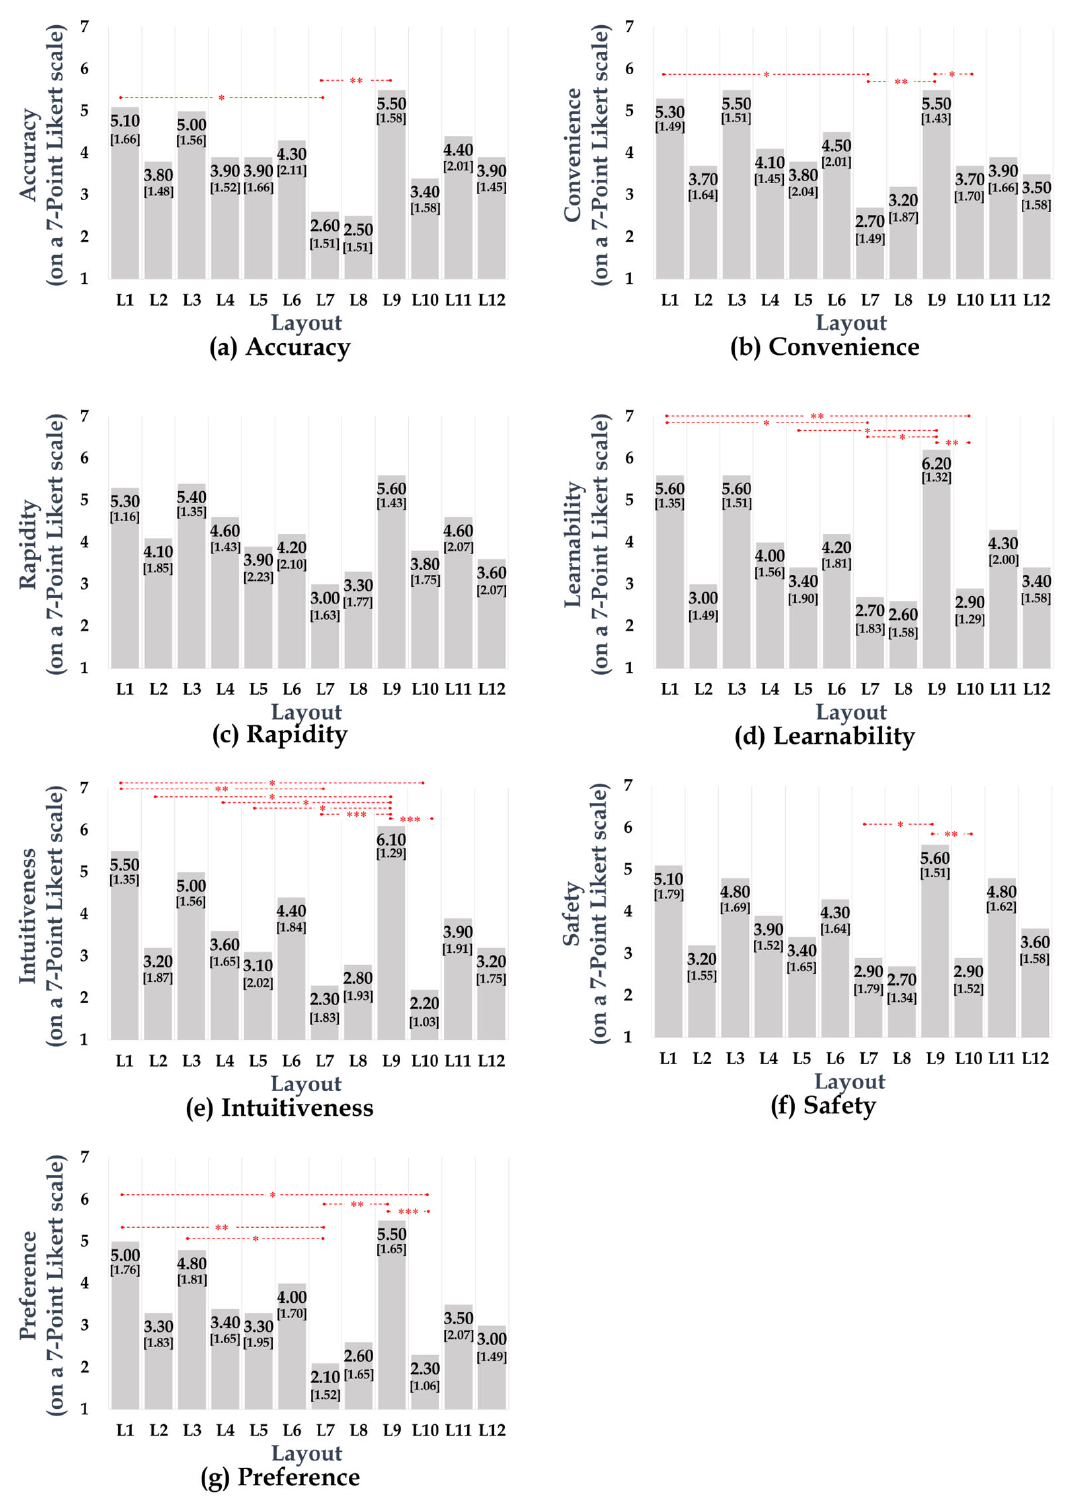
Figure 3. Mean and standard deviation of each subjective rating measure for each layout in the experienced driver group: ( a ) accuracy, ( b ) convenience, ( c ) rapidity, ( d ) learnability, ( e ) intuitiveness, ( f ) safety, and ( g ) preference. * p < 0.05, ** p < 0.01, *** p < 0.001.